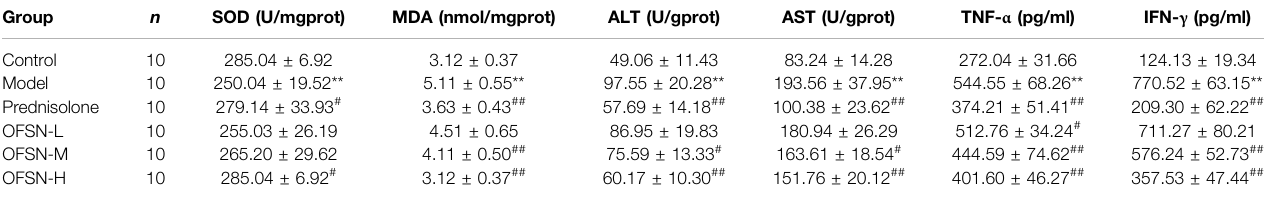
TABLE 9 | Effects of OFSN on biochemical detection of mice ( ‾ x ± s). Group